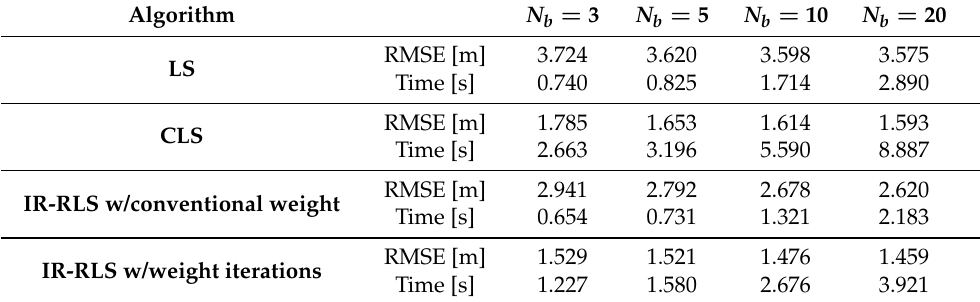
Table 2. RMSE and computational time comparison for different base station